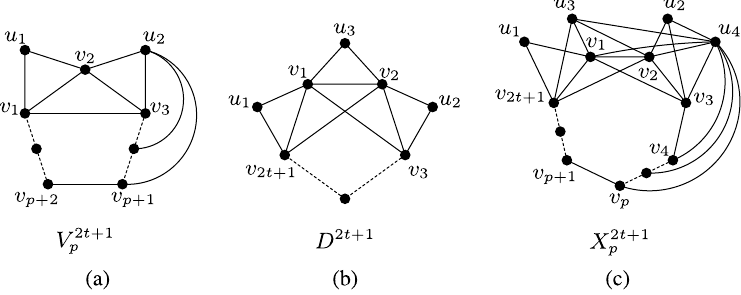
Fig. 5: Families of minimally non-balanced HCA graphs: (a) Family V 2 t +1 p : The dotted paths joining v 3 and v p +1 resp. v p +2 and v 1 represent chordless even paths, not simultaneously empty. All vertices of the dotted path joining v 3 to v p +1 are adjacent to u 2 . (b) Family D 2 t +1 : The dotted path joining v 3 and v 2 t +1 represents a nonempty even path of length 2 t − 2 . (c) Family X 2 t +1 p : The dotted paths joining v 4 and v p resp. v p +1 and v 2 t +1 represent any chordless even paths, both of them possibly empty, even simultaneously. The vertices of the dotted path joining v 4 to v p are all adjacent to u 4